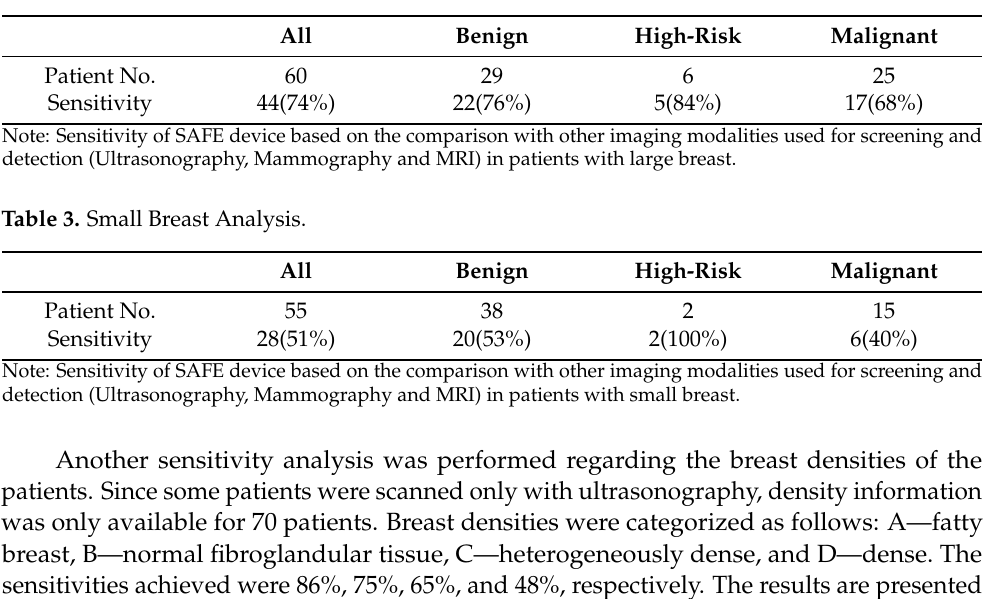
Table 4. Density Analysis. All A B C D Patient